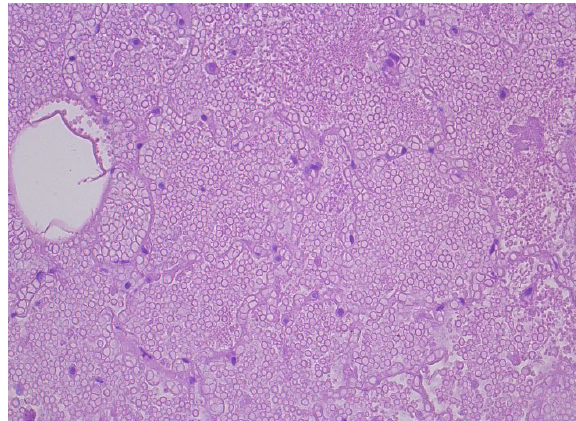
Fig. 13 A. Lungs. The alveoli are filled with red blood cells. McManus. EP 10, lens 20